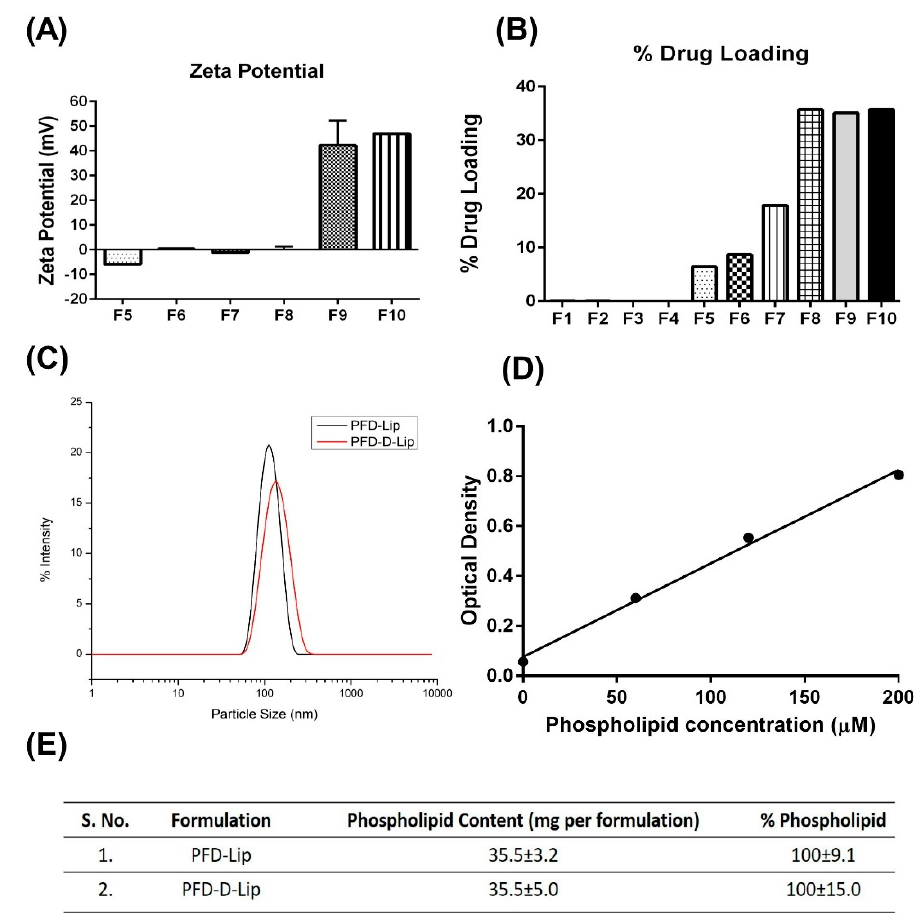
Figure 1. ( A ) Zeta potential of liposomes was determined by a Malvern Zeta Sizer. Zeta potential of F8 and F9 are positive due to the presence of cationic lipid DOTAP. ( B ) % drug loadings were determined for all liposomal formulations. Liposomes formulated using the freeze–thaw technique were found to have the highest amounts of drug loaded. ( C ) Particle size distribution plots of PFD–Lip and PFD–D-Lip. ( D ) Standard curve for phospholipid content performed by using a calorimetric assay ( n = 4). ( E ) Quantification of phospholipid content in liposomal formulations ( n = 4).